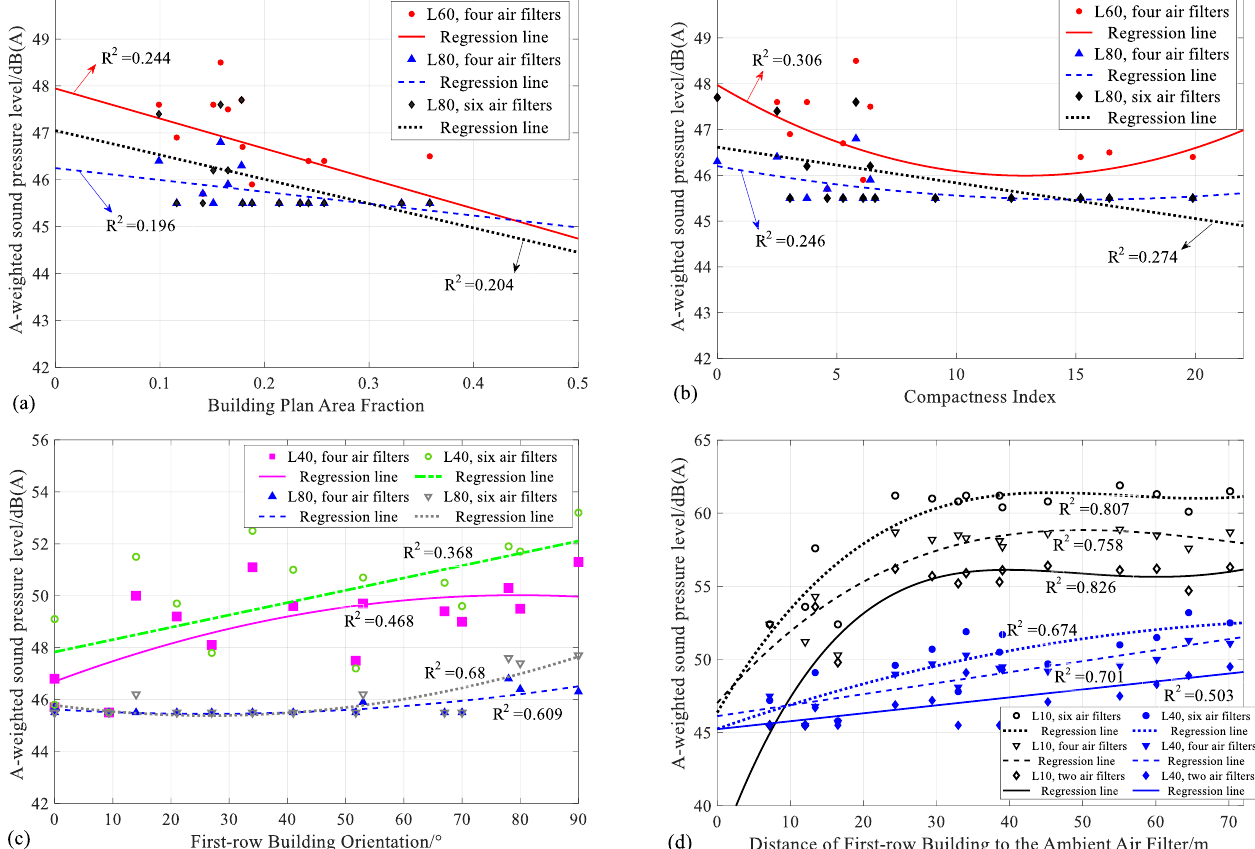
Figure 8. Correlations between noise indices and urban form indices (( a ) Building Plan Area Fraction; ( b ) Compactness Index; ( c ) First-row Building Orientation; ( d ) Distance of First-row Building to the Ambient Air Filter).